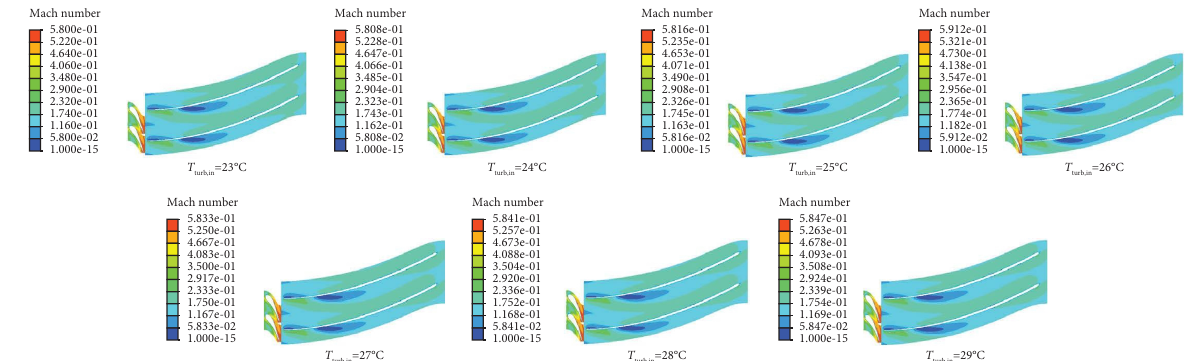
Figure 17: Distribution of Mach number at the half-blade height with turbine inlet